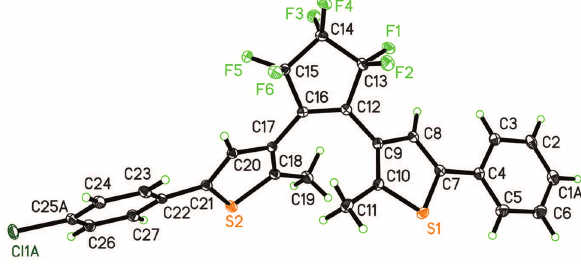
Table 1: Data collection and